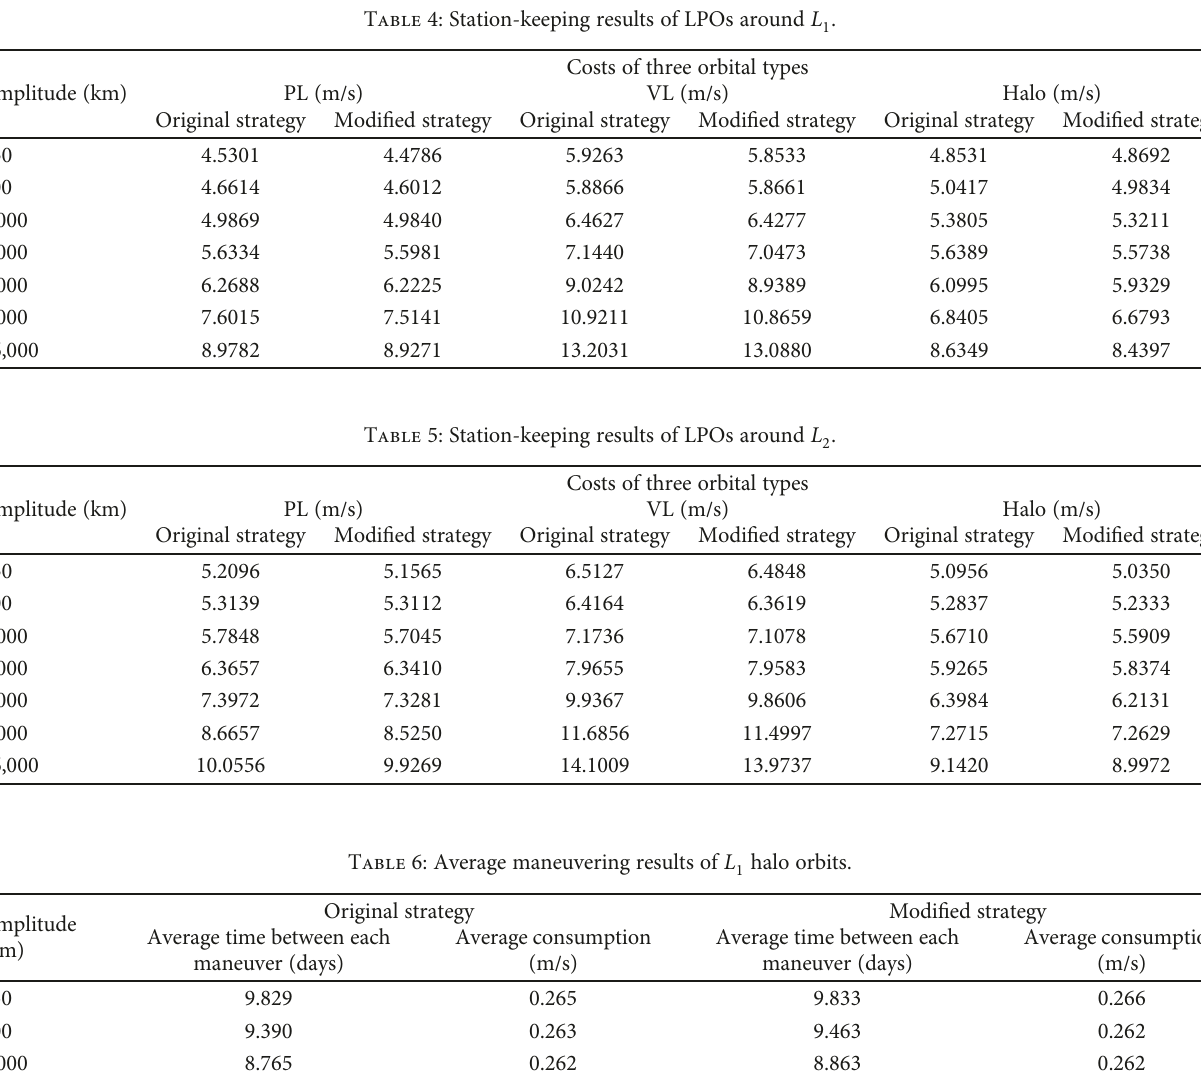
Table 4: Station-keeping results of LPOs around L